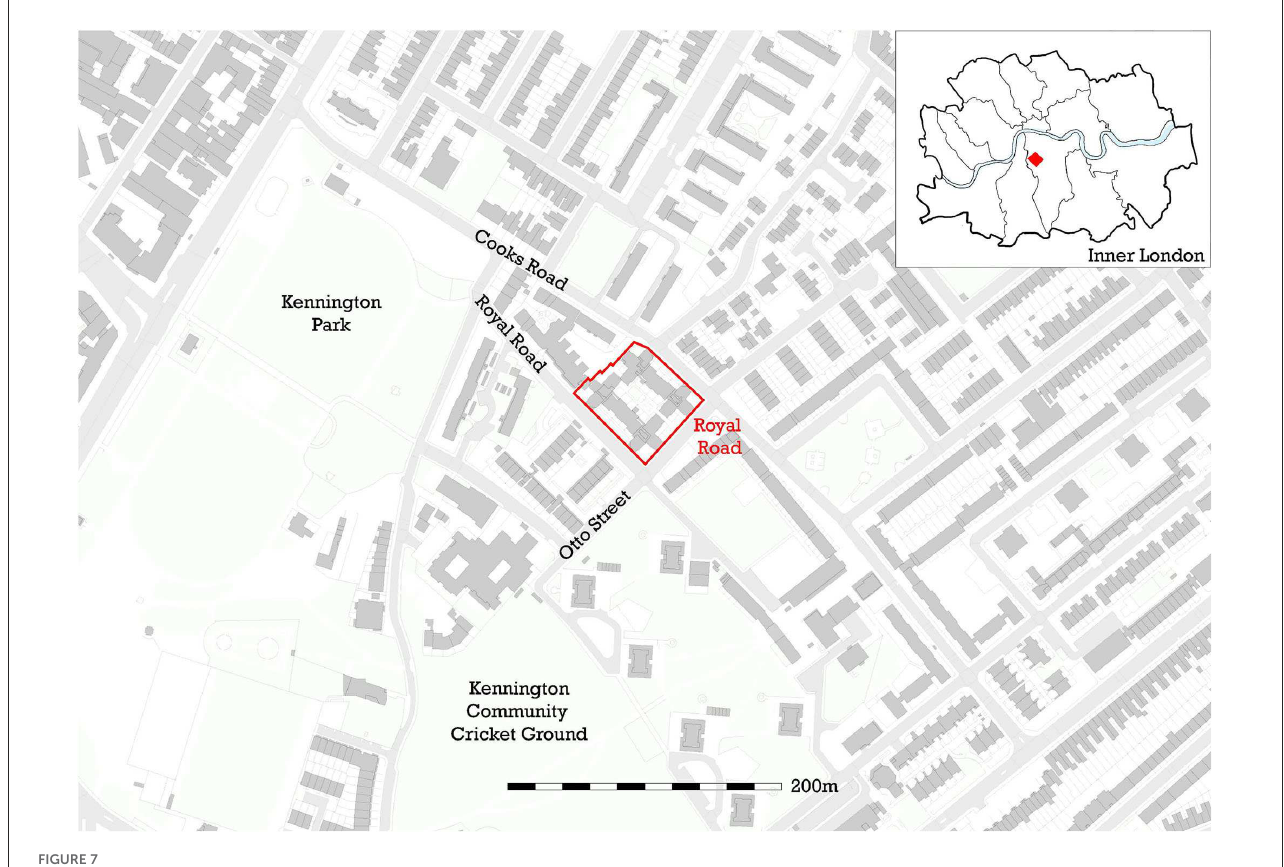
FIGURE7 Location of Royal